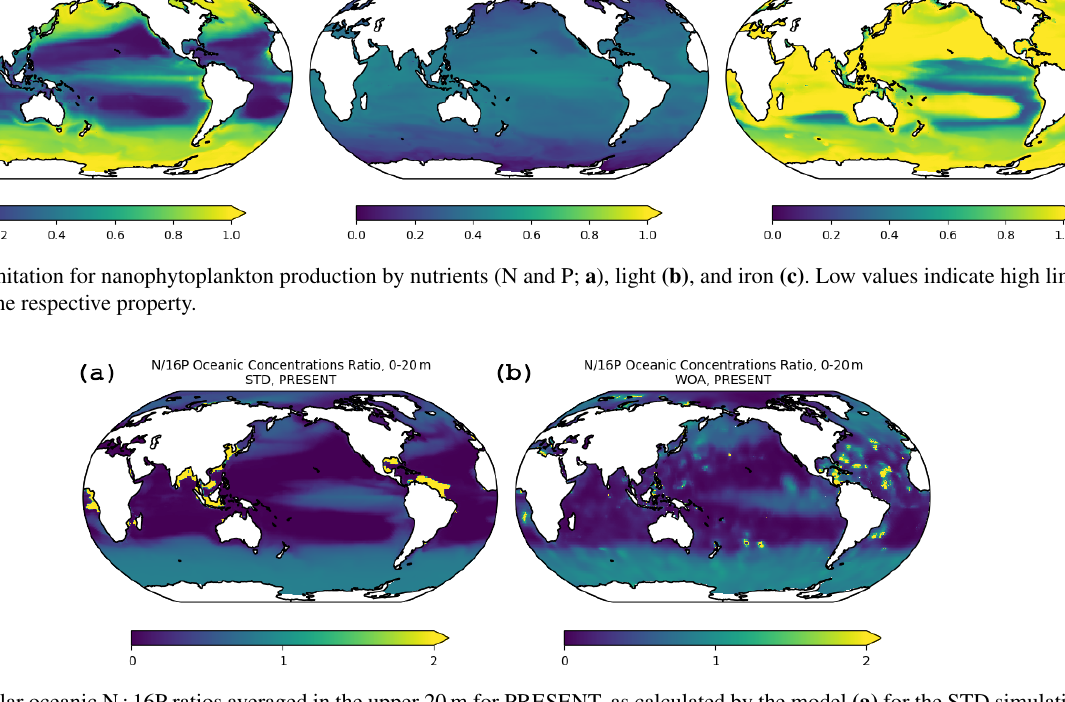
Figure 5. Molar oceanic N:16P ratios averaged in the upper 20m for PRESENT, as calculated by the model (a) for the STD simulation, and as derived by the World Ocean Atlas (WOA; Garcia et al., 2010b) data (b) . Values > 1.0 denote overshoot of N vs. P relative to the Redfield ratio (C:N:P = 122:16:1); blue areas indicate a surplus of P or deficiency of